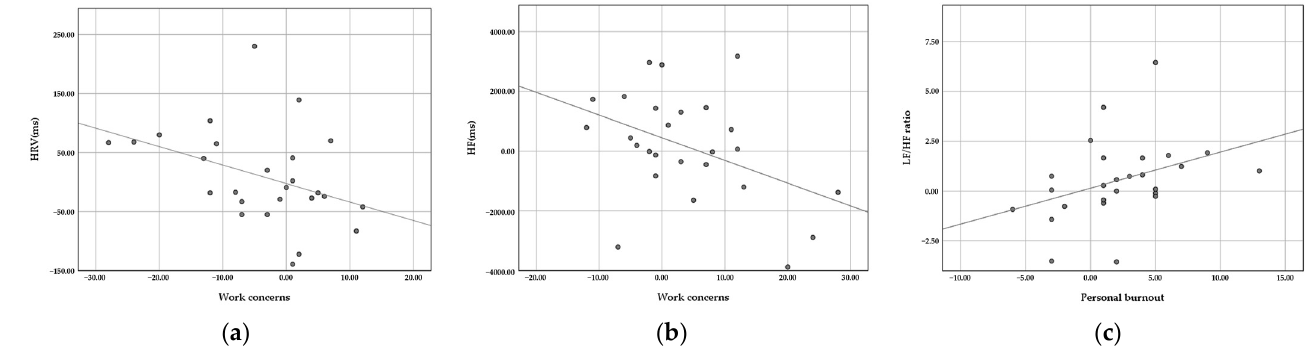
Figure 6. Correlation scatter plot of physiological and psychological responses: ( a ) HRV-Work concerns; ( b ) HF-Work concerns; and ( c ) LF/HF ratio-Personal burnout.